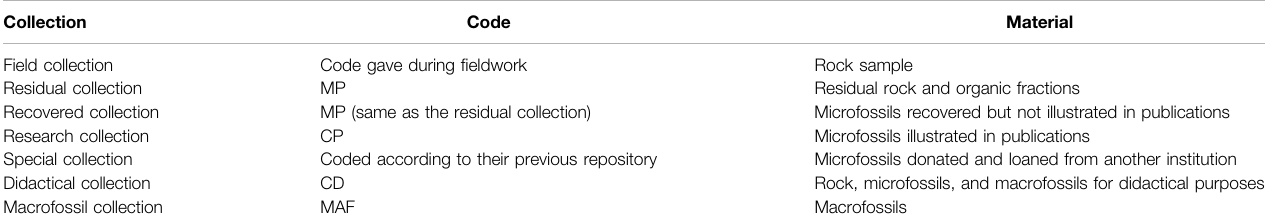
TABLE 2 | Collections into the paleontological collection of the Museum of Geosciences, University of Brasilia. Collection